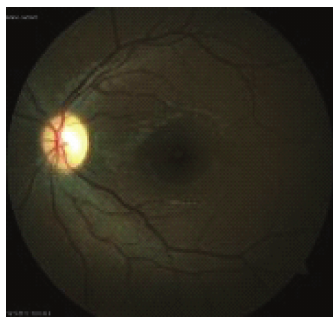
Figure 2: Fundus photograph of the left eye at initial examination.